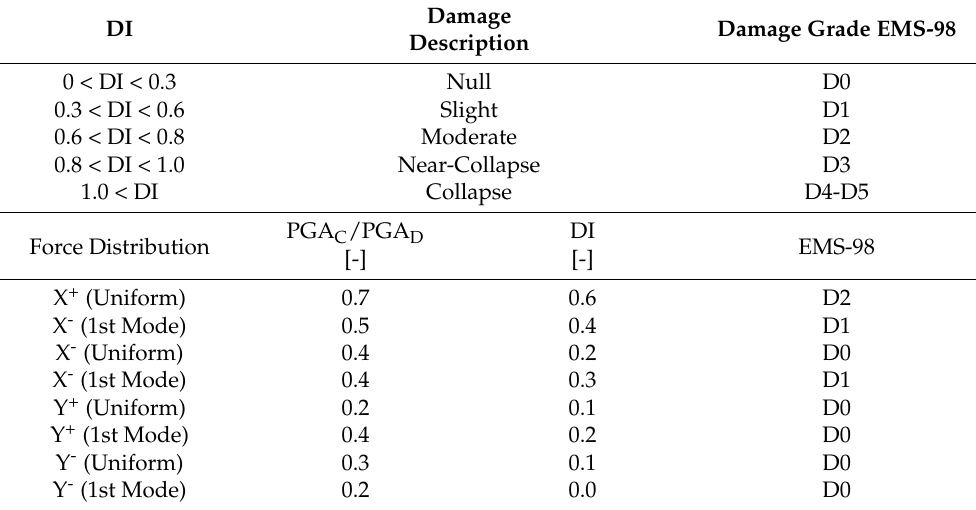
Table 3. Correlation between DI and European Macroseismic Scale (EMS-98) damage levels. Damage DI